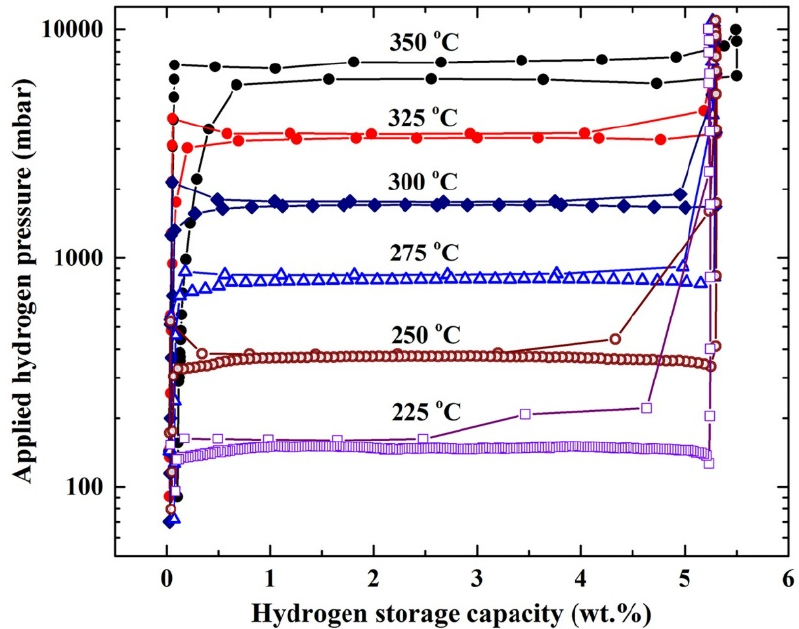
Figure 6. Pressure-composition-temperature (PCT) curves of ball-milled MgH 2 /5.2 TiC/4.6 FeCr nanocomposite powders obtained after 50 h at different temperatures of 225, 250, 275, 300, 325, and 350 °C.